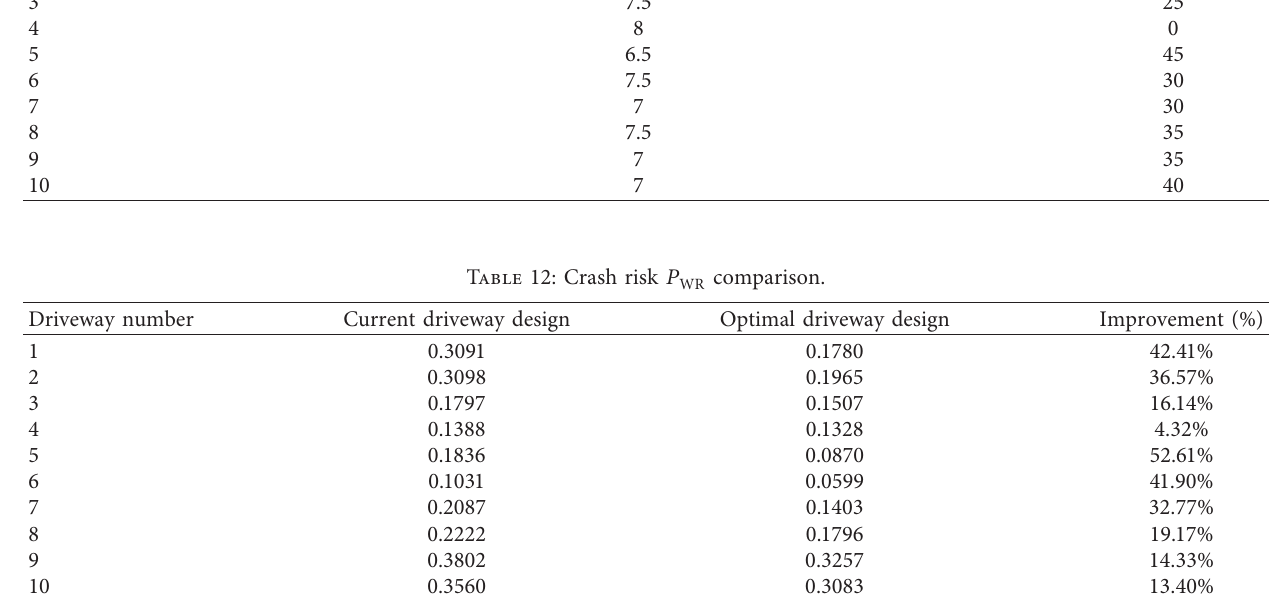
, W , and R for driveways. (a) Driveway 2. (b) Driveways 3 and 4. (c) Driveway 5. (d) Driveway WR c Table 11: Optimal driveway design.